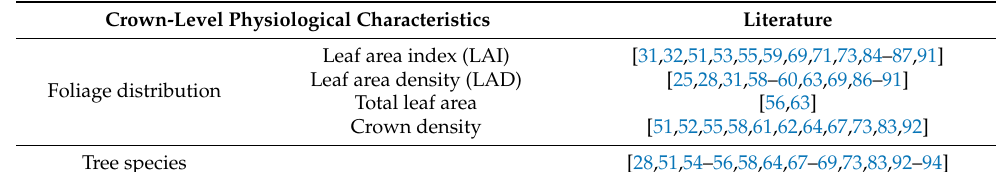
Table 3. Crown-level physiological characteristics of trees summarized from the